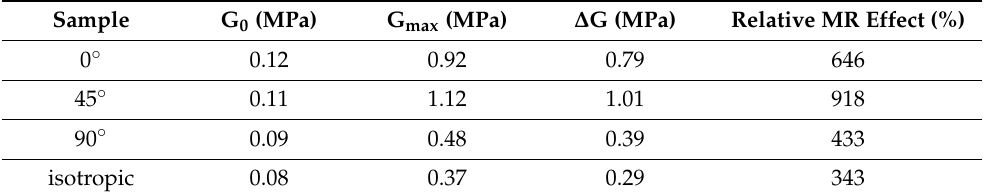
Table 3. The initial storage modulus (G 0 ), the magnetic-induce modulus ( ∆ G) and the MR effect of MRE samples with different mold orientations.